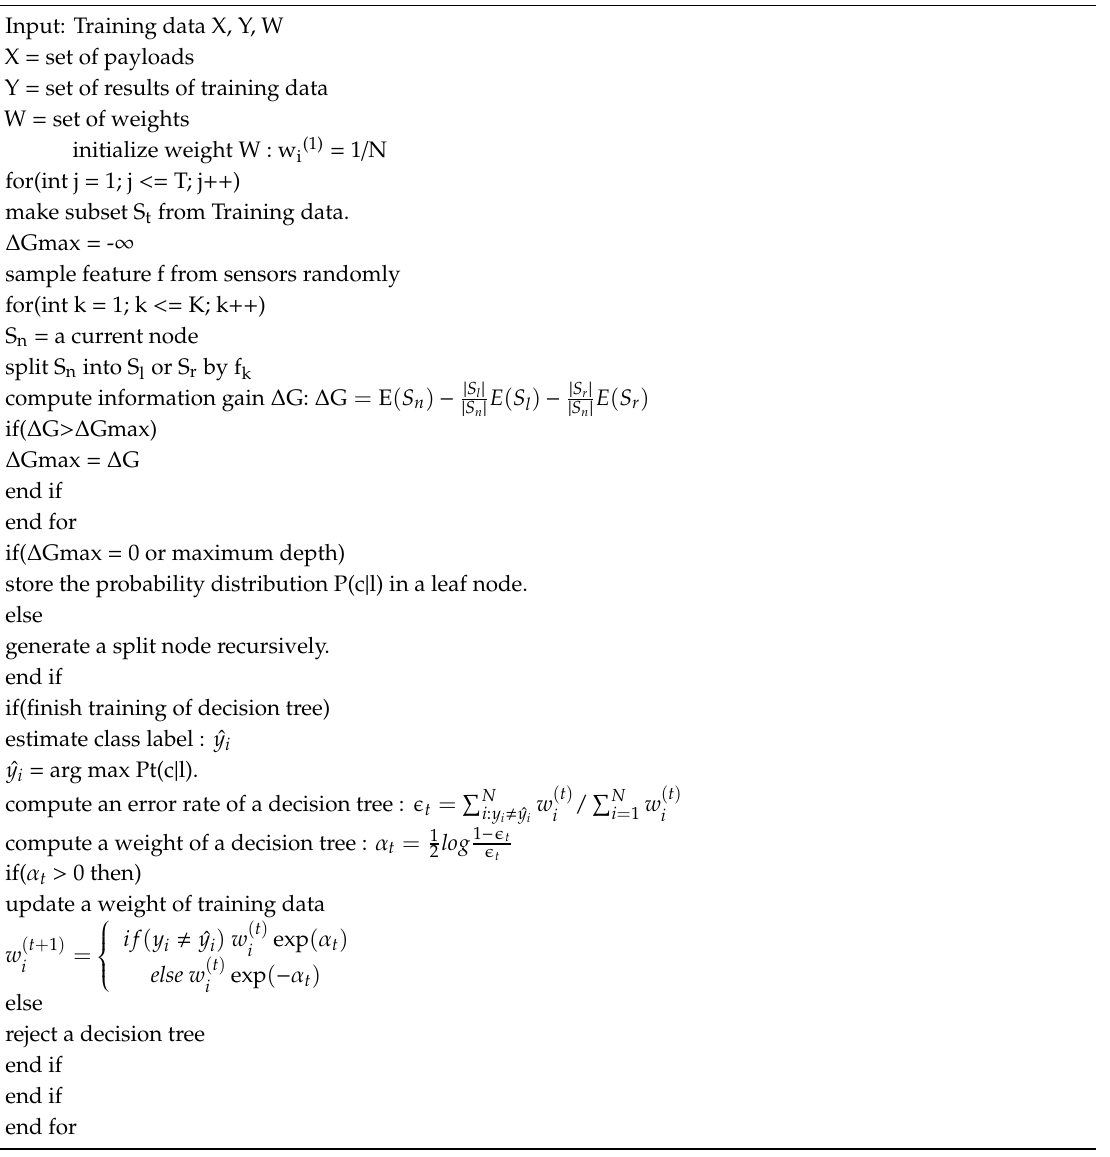
Algorithm 1. The process generating a random-forest